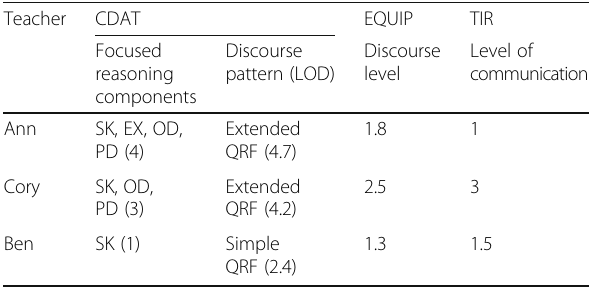
Table 7 Comparisons between the three methods (EQUIP, TIR, and